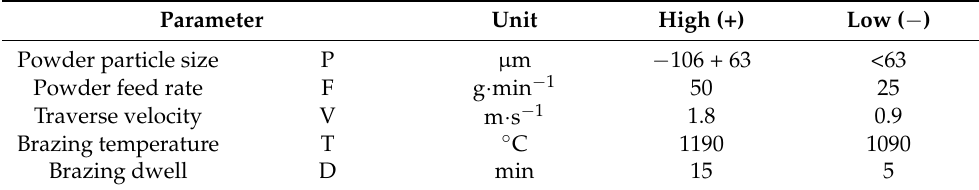
Table 3. Process parameters used in the DOE.